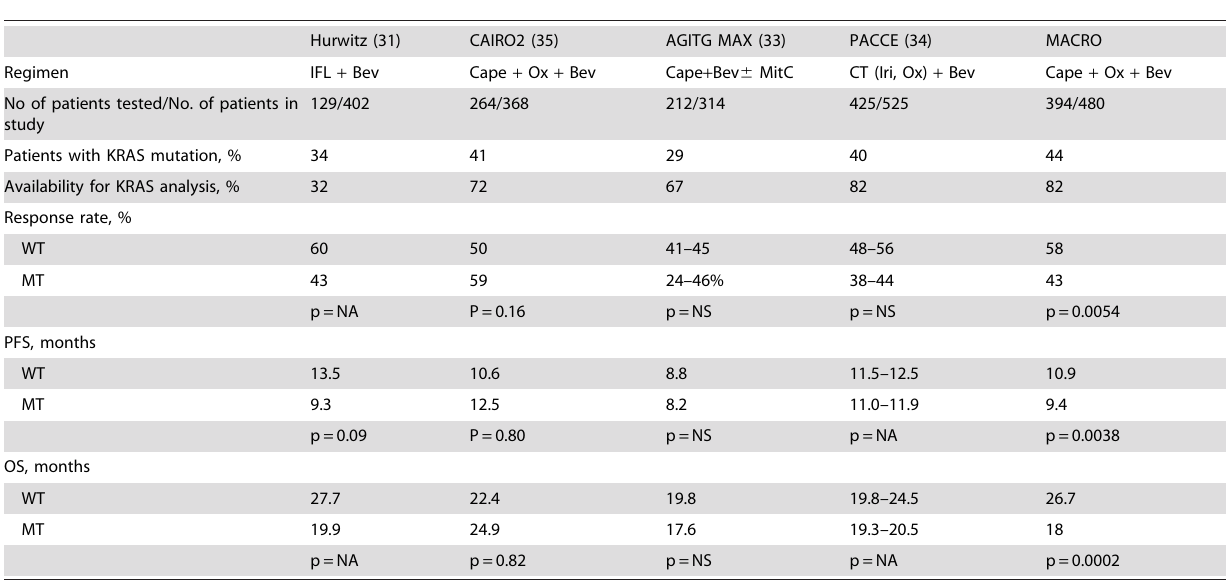
Table 5. Summary of KRAS data from larger studies of bevacizumab + chemotherapy in patients with metastatic colorectal